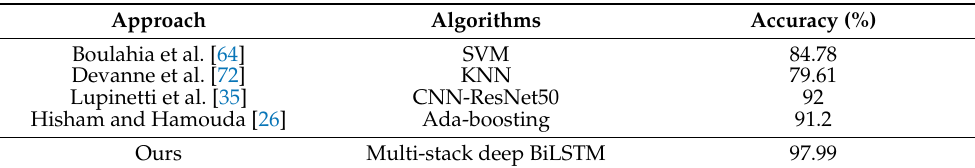
Table 14. Performance of the multi-stacked BiLSTM network initialized with data-driven optimization applied to LMDHG data